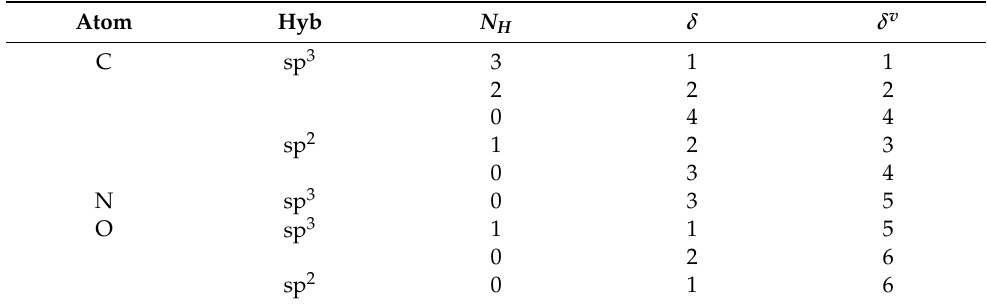
Table 1. δ and δ v values used for calculation of zero—and first-order connectivity indices [32].